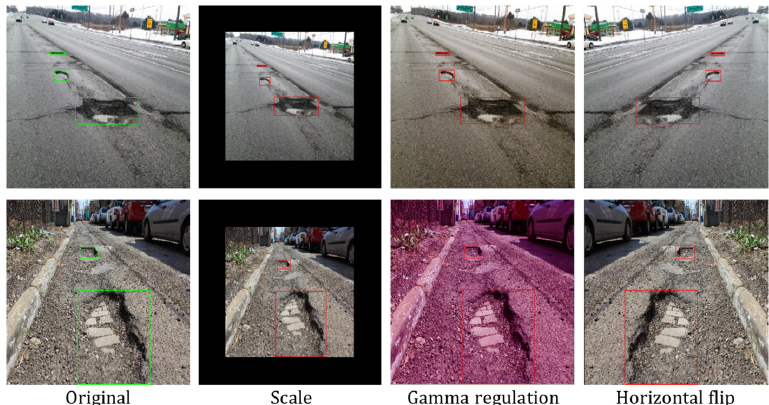
Figure 2. Pothole images subset after data augmentation.